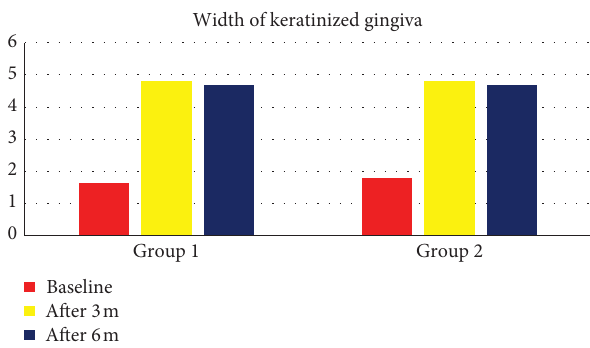
Figure 3: Bar chart representing the width of keratinized gingiva for different groups at different time